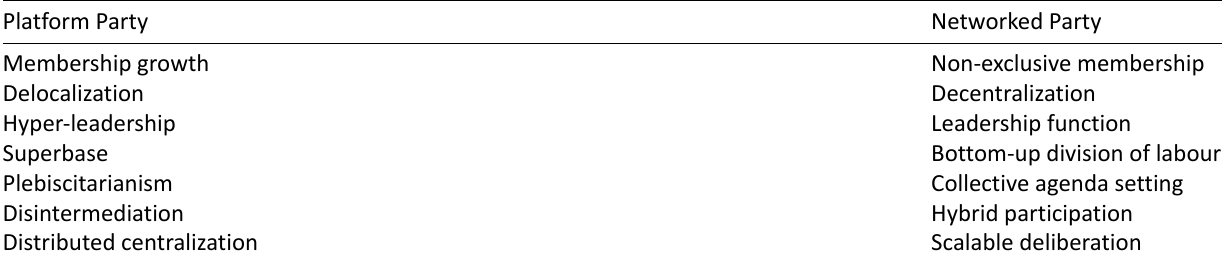
Table 1. The keywords of platform party and networked party.